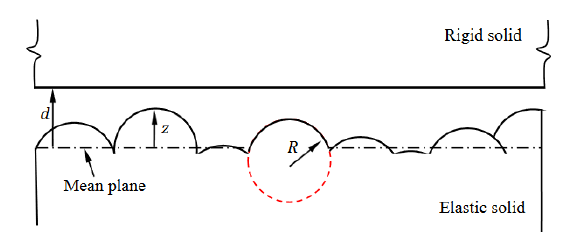
Figure 1. Greenwood Williamson model for rough